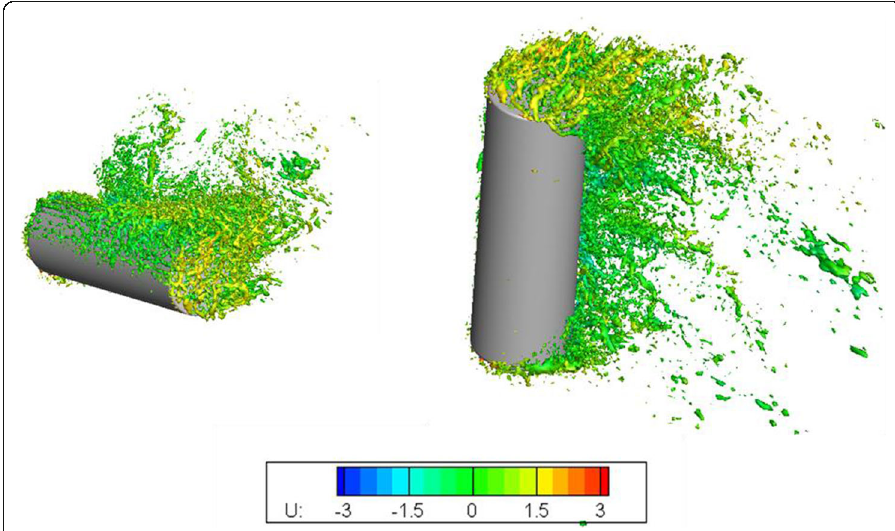
Fig. 13 Instantaneous Q criterion ( Q = 100) for Magnus rotor with AR = 3. Isosurface is colored by the normalized streamwise velocity ( U / U ∞